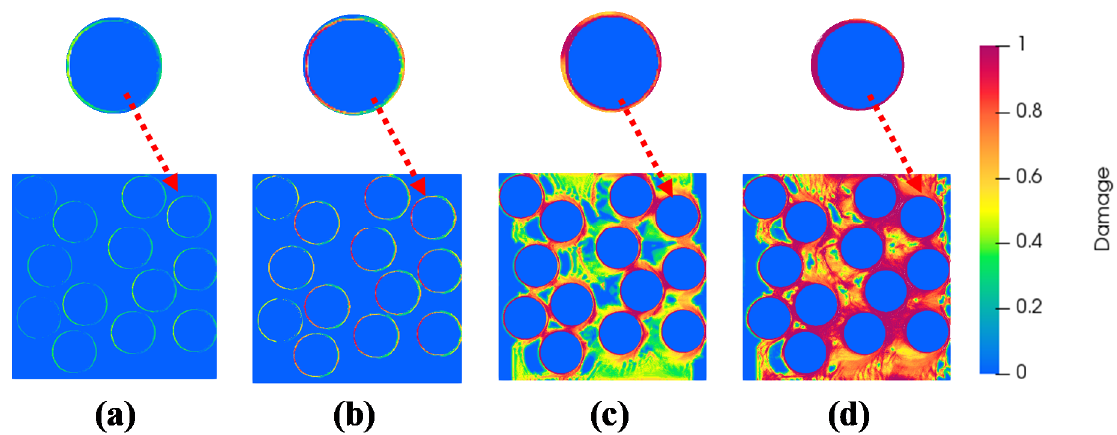
Figure 7. Progressive damage (interface/matrix) observed in iron powder (10%) modified mortar corresponding to applied tensile strains of ( a ) 52 µε , ( b ) 105 µε, ( c ) 153 µε and ( d ) 208 µε (the interface damage is highlighted in zoomed pictures).